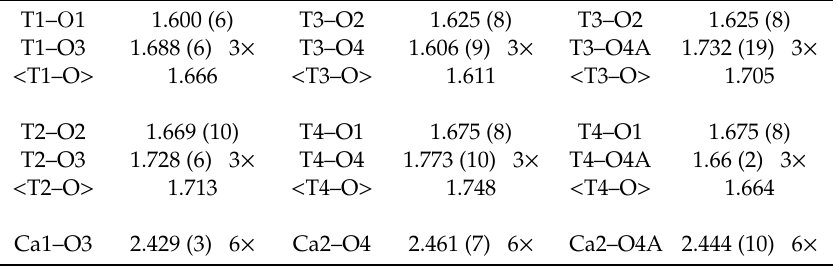
Table 3. Selected bond lengths (Å) in the crystal structure of